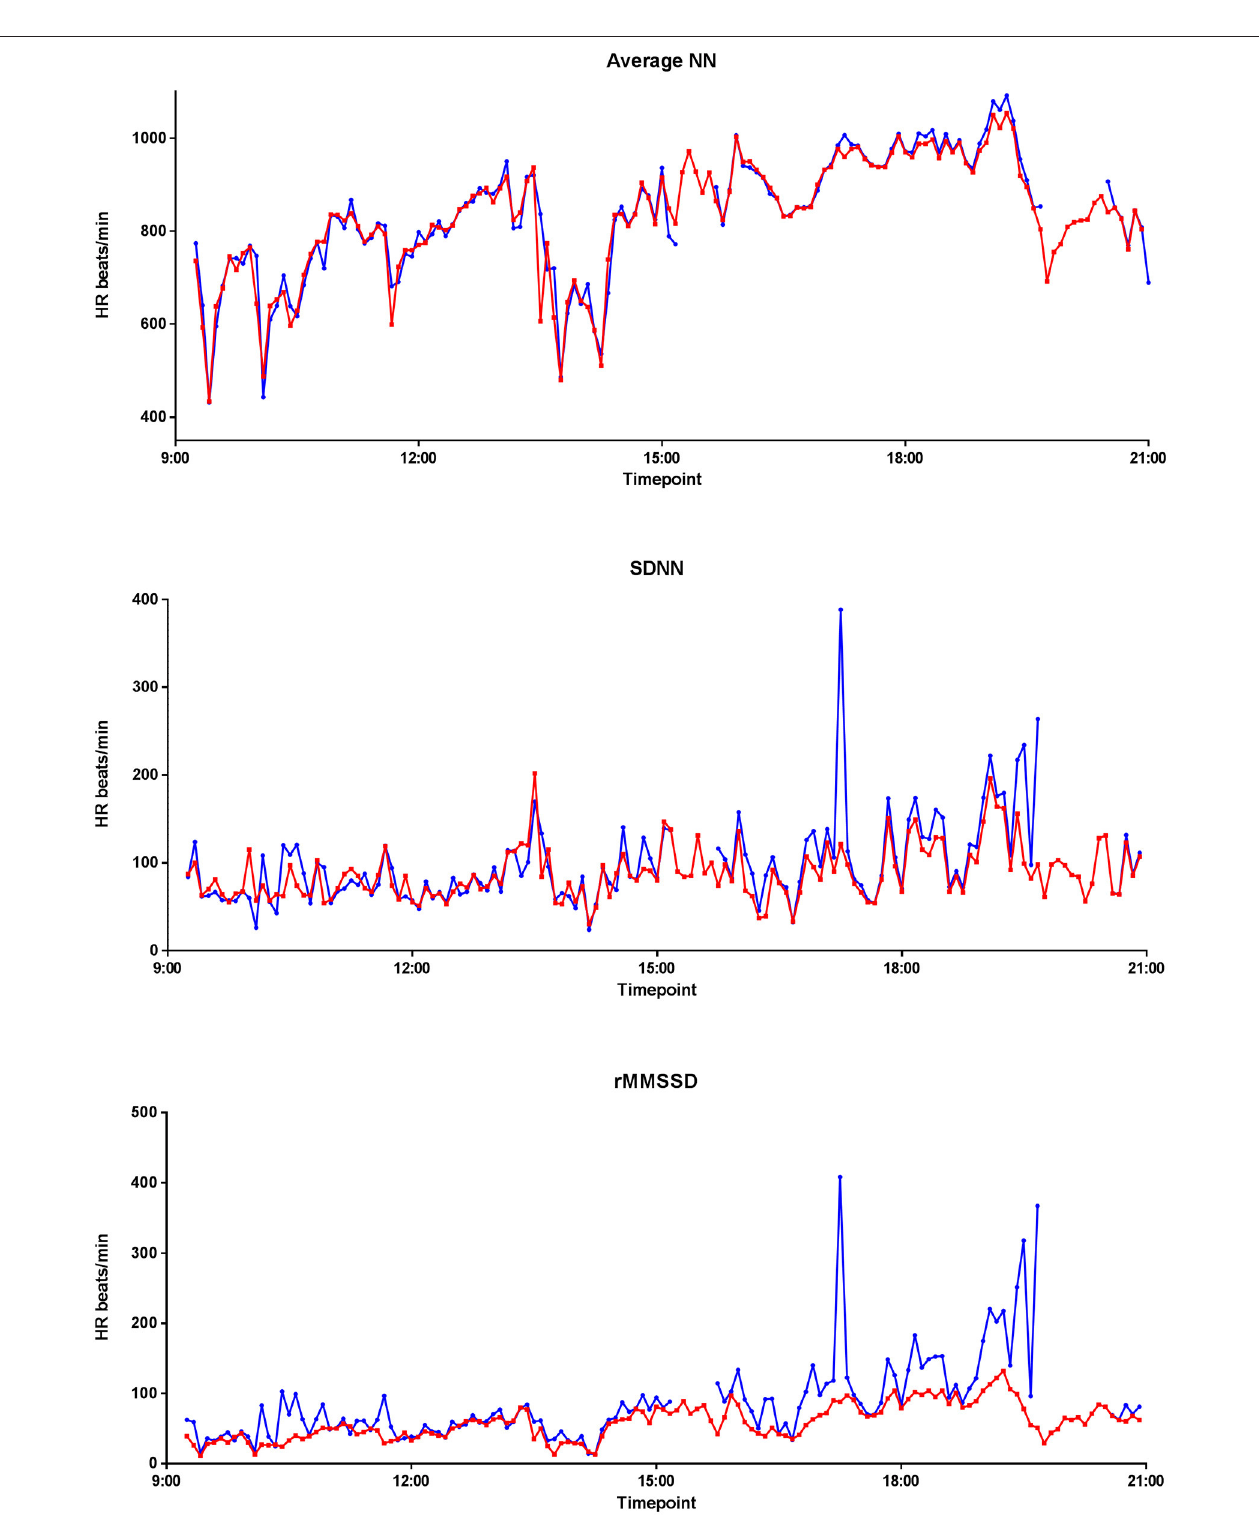
FIGURE 7 | Twenty four hour EQ02 and Holter HRV profile. Average NN, SDNN, and rMMSD of a participant over 24 h, as recorded by the Holter (red) and EQ02 (blue).